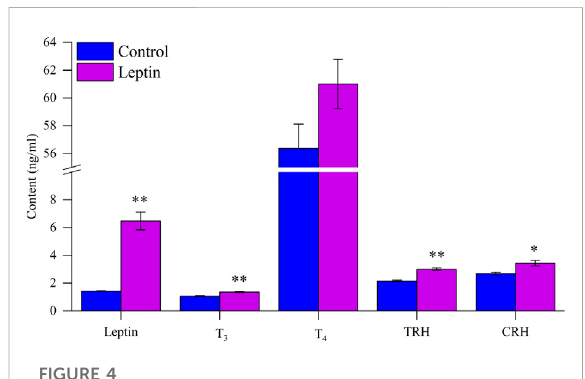
FIGURE 4 Effect of leptin on serum hormone levels in Eothenomys miletus . *: p < .05, **: p < .01 indicates a signi fi cant difference between the leptin and control groups.